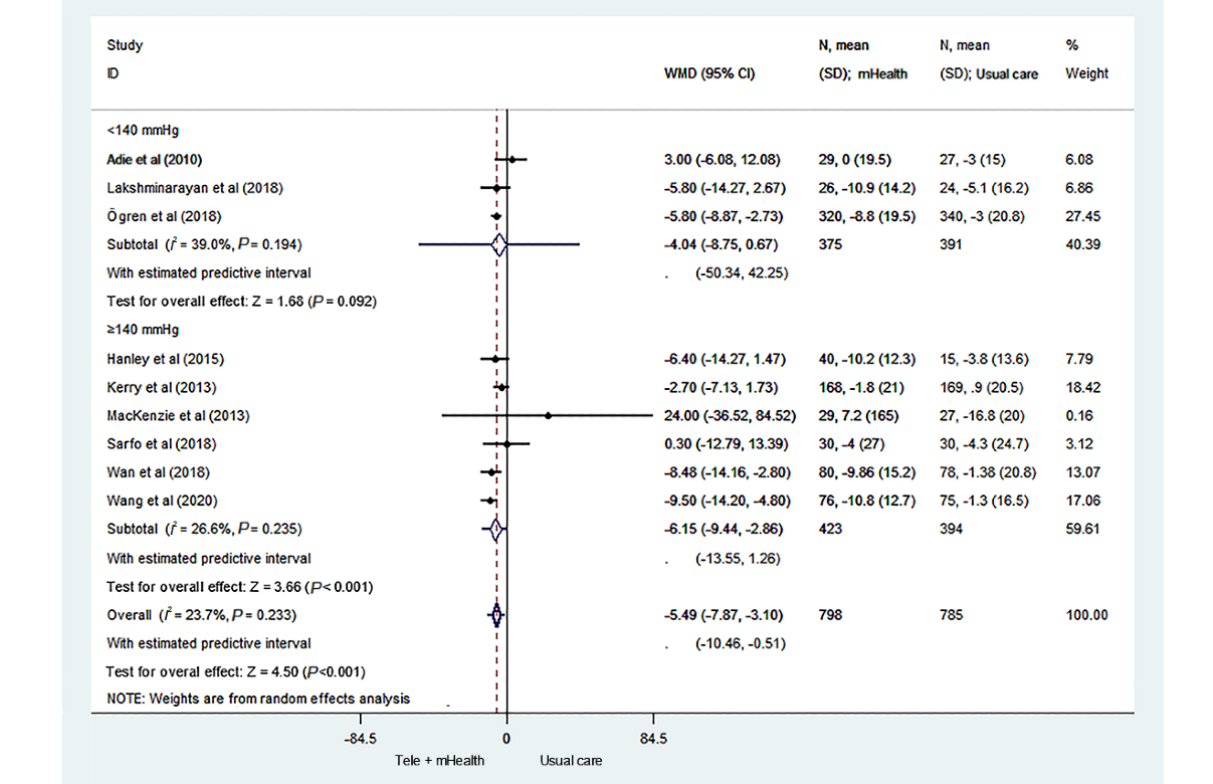
Figure 5. Forest plot of the subgroup analysis of the baseline systolic blood pressures. mHealth: mobile health; WMD: weighted mean